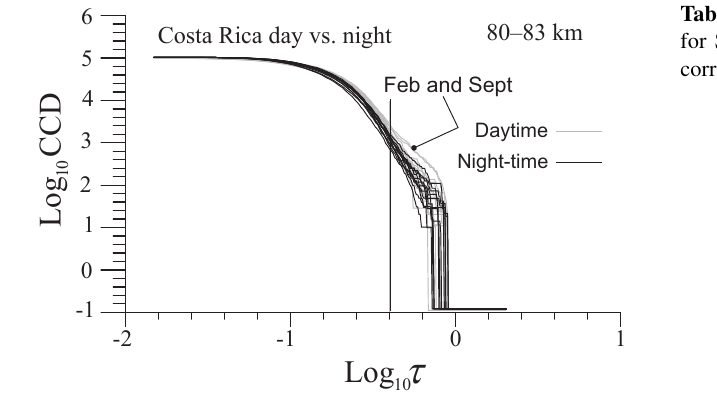
Figure 3. CCDs for Costa Rica at 80–83km altitude for all months over all years of observations. Data are grouped according to day- time (grey) and night-time (black). Twelve graphs of each shade (grey or black) appear, one for each month of the year, but the months are not otherwise distinguished. Two unusual months are shown (February and September). In this case, the day and night CCDs are harder to separate, but differences do exist, as will be seen later in Fig. 8. See text for further discussion.